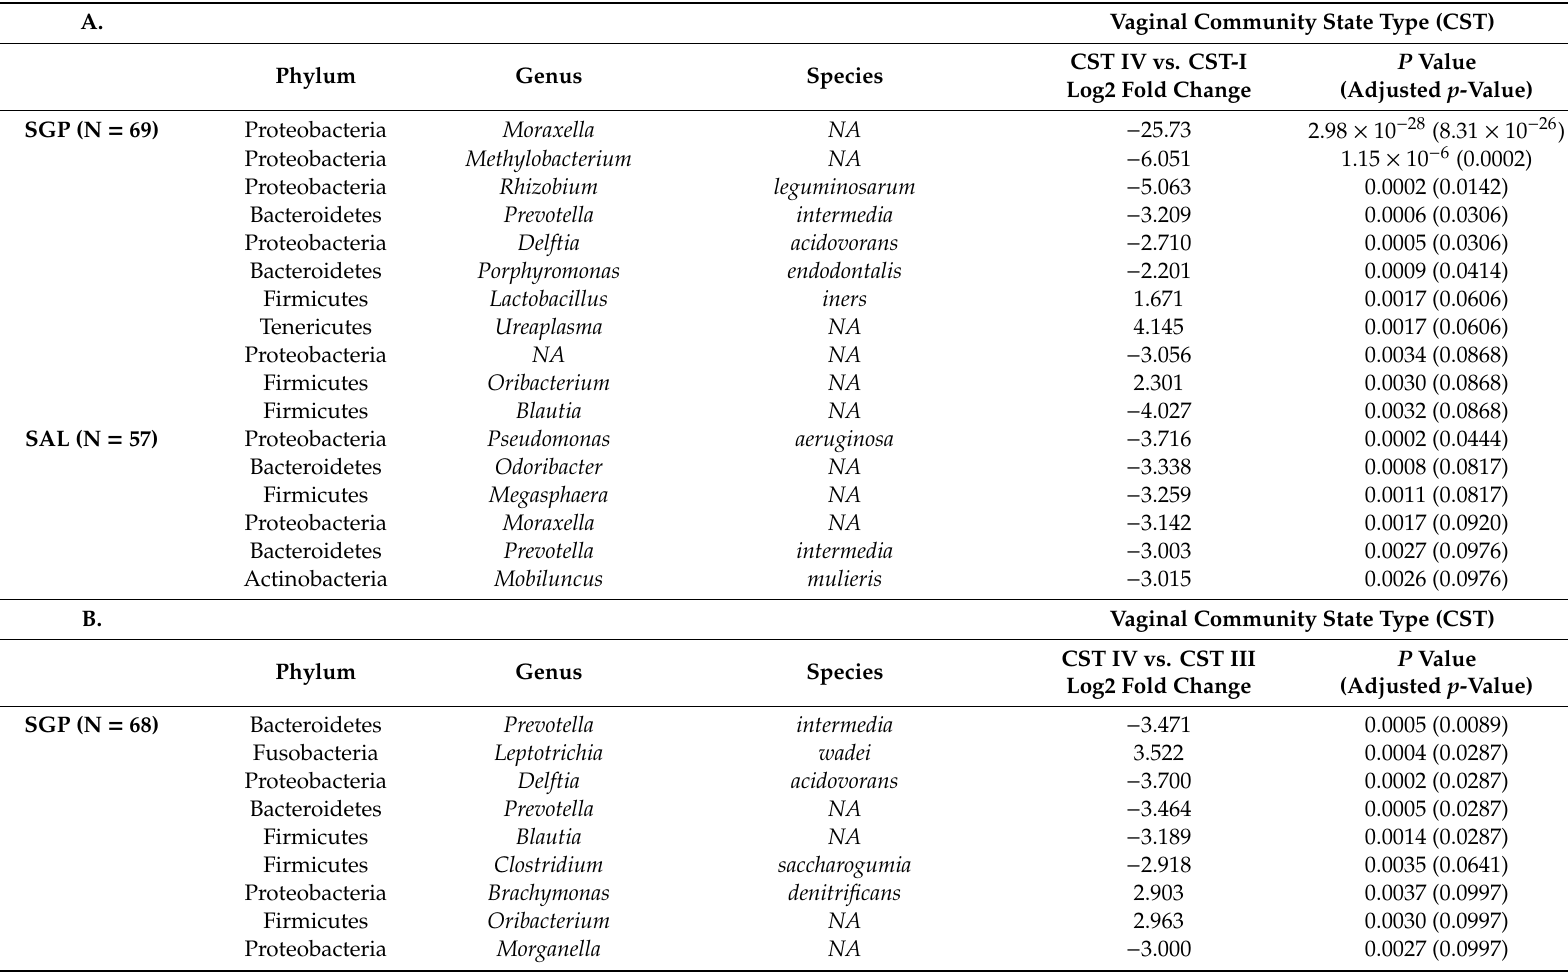
Table 3. Results of a DESeq2 to assess di ff erences in the relative abundance of supragingival (SGP) and salivary (SAL) bacterial taxa between participants with di ff ering vaginal community state types ((A) CST-IV versus CST-I, (B) CST-IV versus CST-III and (C) CST-I versus CST-III) and (D) participants with and without BV (BV negative as